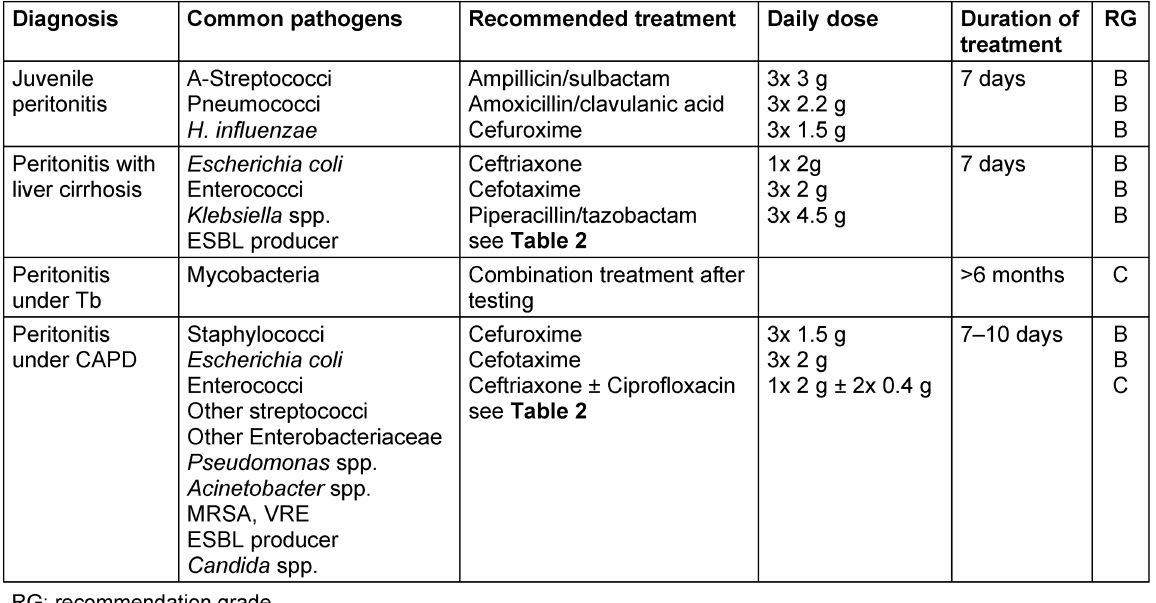
Peritonitis Primary peritonitis